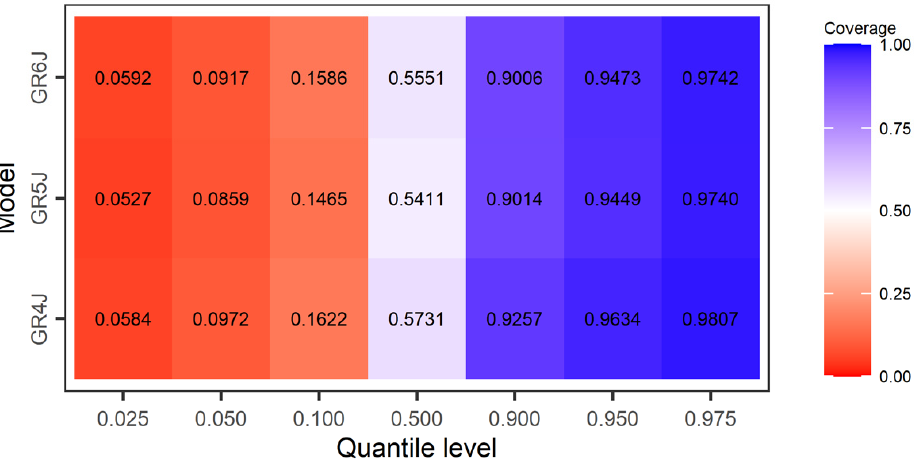
Figure 7. Heatmap of the median coverages of the predictions issued by the GR4J, GR5J and GR6J hydrological models at varying quantile levels summarizing the results for the 511 river basins.